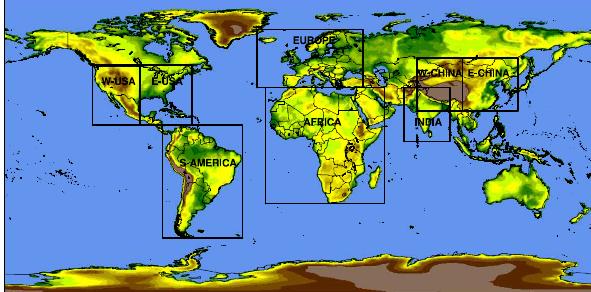
Figure 1. The separately analyzed areas: western United States (W- USA), eastern United States (E-USA), South America (S-America), Europe, Africa, India, western China (W-China) and eastern China